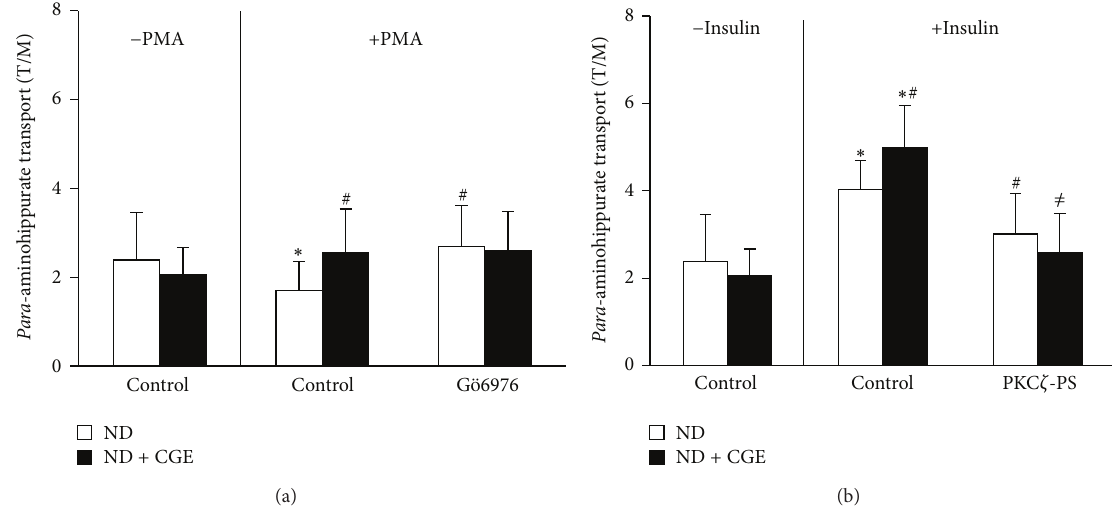
Figure 7: Effects of Cladophora glomerata extract on regulatory function of rOat1 and rOat3 functions. (a) Downregulation of rOat1 and 3 by PMA-inhibited PKC 𝛼 activity. Rat renal cortical slices were preincubated for 30 min in the presence or absence of 100nM of PMA or PMA with G ¨O6976 and followed by incubation with 5 𝜇 M of [ 3 H]-PAH for 30 min. Data are expressed as tissue to medium ratios (T/M) ( 𝑛 = 5 ). ∗ 𝑃 < 0.05 indicates significant differences from control. # 𝑃 < 0.05 indicates significant differences from PMA preincubation in renal slices from ND. (b) Upregulation of rOat1 and 3 by insulin-stimulated PKC 𝜁 activity. Rat renal cortical slices were preincubated for 30 min in the presence or absence of 30 𝜇 g/mL of insulin or insulin with PKC 𝜁 -PS and followed by incubation with 5 𝜇 M of [ 3 H]-PAH for 30 min. Data are expressed as tissue to medium ratios (T/M) ( 𝑛 = 5–7). ∗ 𝑃 < 0.05 indicates significant differences from respective control. # 𝑃 < 0.05 indicates significant differences from insulin preincubation in renal slices from ND. ̸= 𝑃 < 0.05 indicates significant differences from insulin preincubation in renal slices from ND + CGE.